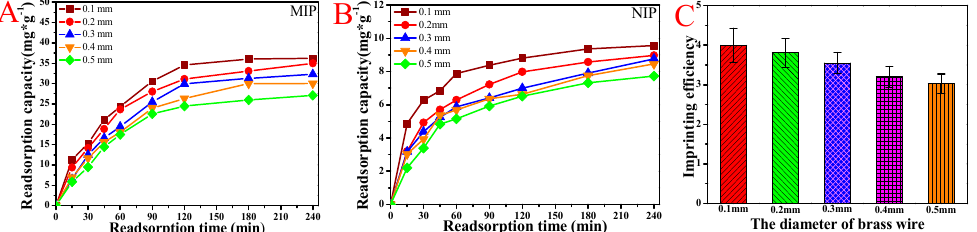
Figure 6. The rebinding curves ( A ) and imprinting efficiency ( C ) of MIP CaAlg membranes scraped with different diameter brass wires; the rebinding curves ( B ) of NIP scraped with different diameter brass wires. NaAlg concentration: 2.5 wt.%; pH of BSA solution: 6.2; and pH of Tris-HCl: 8.1.